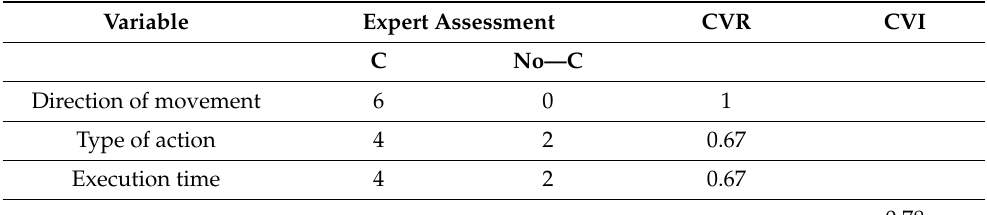
Table 1. CVR and CVI. The content validity index (CVI) revealed a high degree of consensus among the judges who evaluated the test.